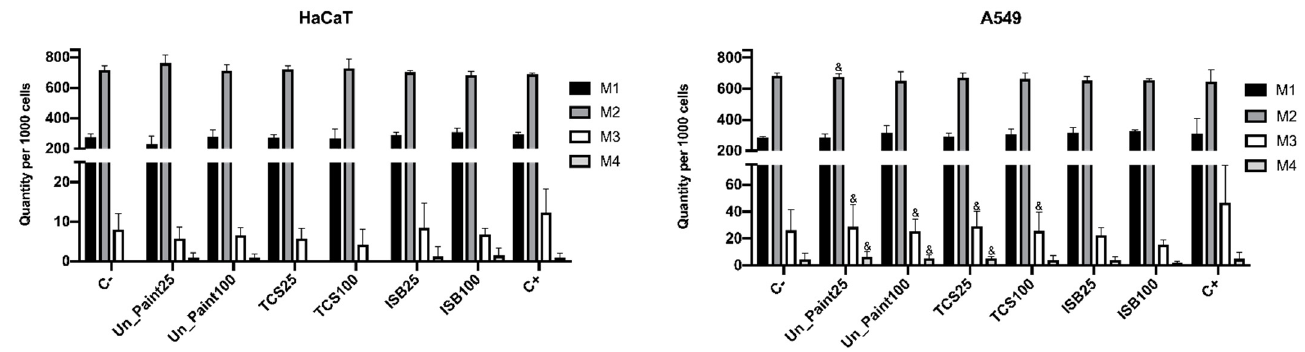
Figure 6. Quantity per 1000 cells of mononucleated (M1), binucleated (M2), trinucleated (M3) and tetranucleated (M4) cells of HaCaT ( left ) and A549 ( right ) cell lines, after exposure to extracts of the samples (in the x axis) Un_Paint, TCS or ISB extracts for 24 h. C- negative control (complete medium), C+ positive control (MMS 800 µM solution). The values are expressed as mean ± standard deviation. The statistical significance of samples compared to C- is represented by * (Two-way ANOVA; p < 0.05). The statistical significance of samples compared to Un_Paint is represented by # (Two-way ANOVA; p < 0.05). The statistical significance of the extract on A549 cells compared to the same extract, in the same concentration, on HaCaT cells is represented by & (Two-way ANOVA; p < 0.05).